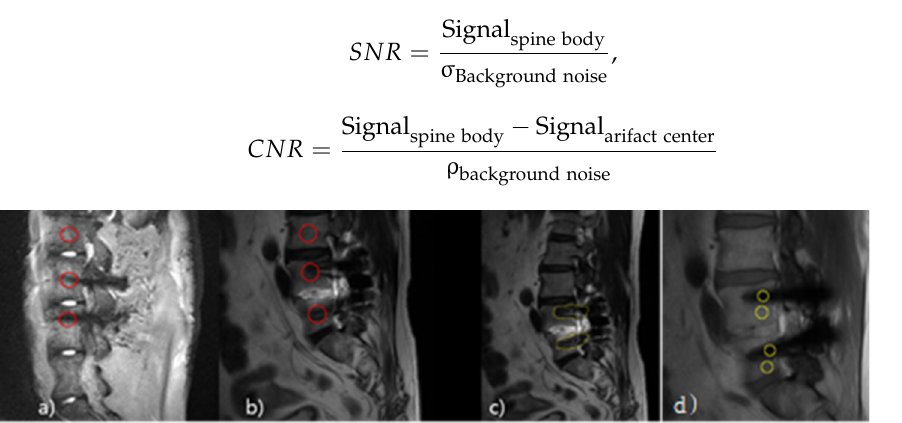
Figure 2. Location of the region of interest (ROI) in Pig L-spine Phantom and transplant patients. Pig L-spine Phantom ROI ( a ); Transplant patient ROI ( b ); Transplant patient Histogram ROI ( c ); Transplant patient CNR ROI ( d ), Circle: Signal Intensity.